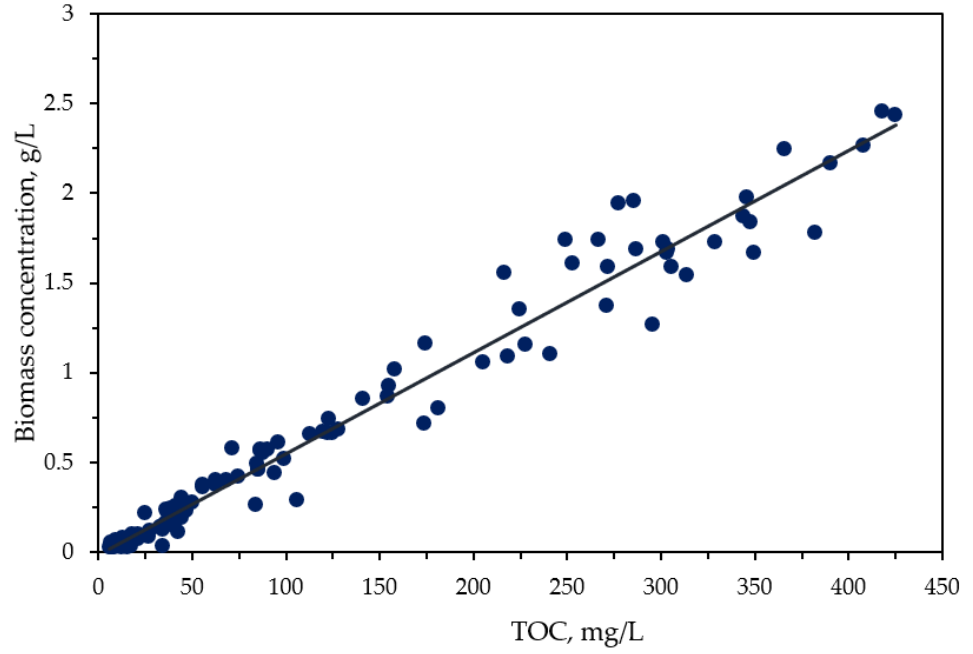
Figure 5. Linear relationship between biomass concentrations of the microalga Chlorella vulgaris versus total organic carbon (TOC) values.